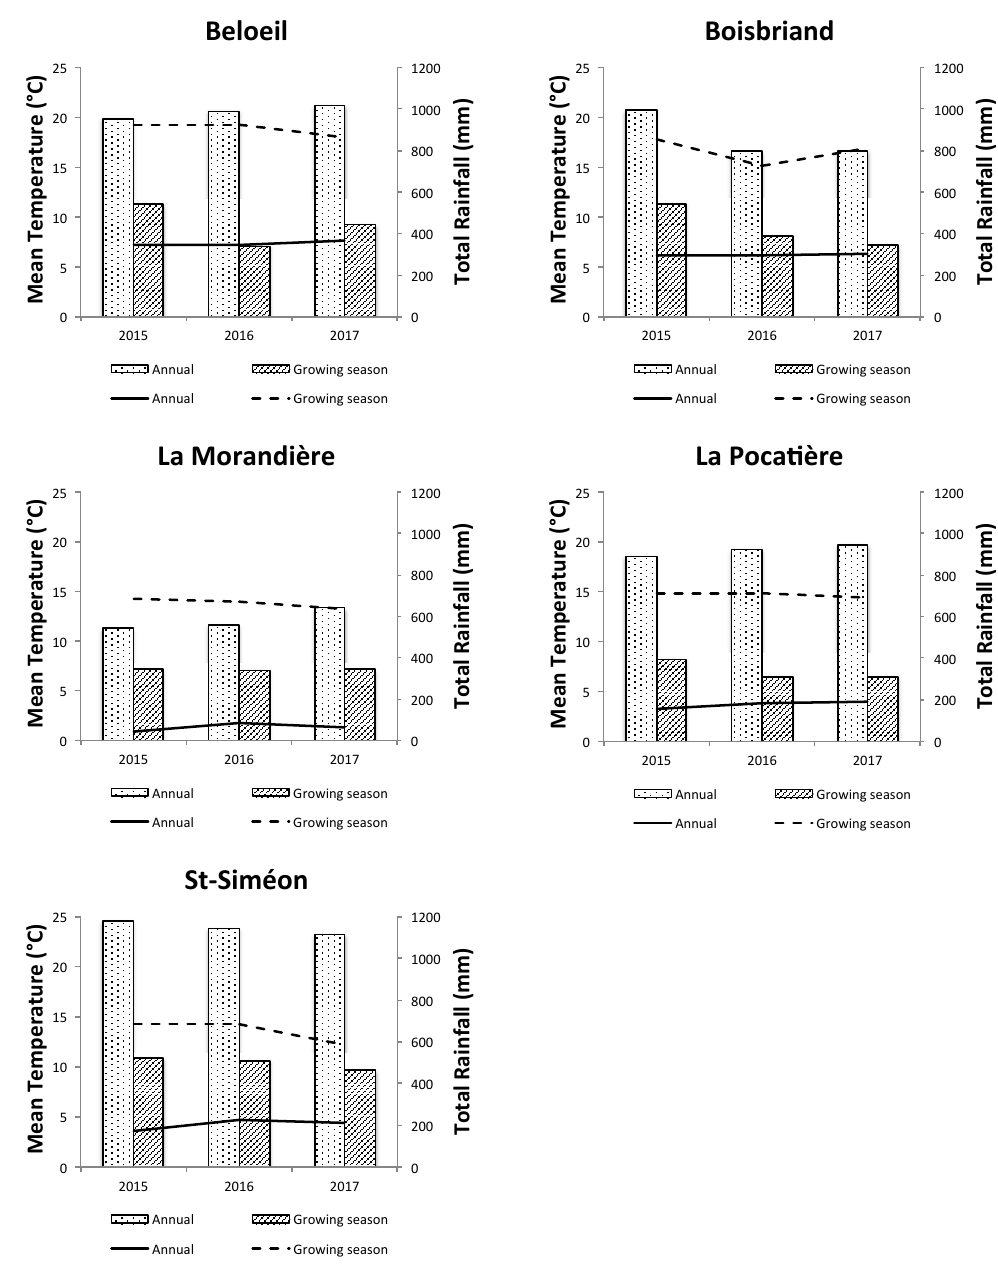
Figure 1. The mean temperature and rainfall on an annual basis and during the growing season (May–September 2015–2017) at different experimental sites. Bars represent annual precipitation and lines temperature.